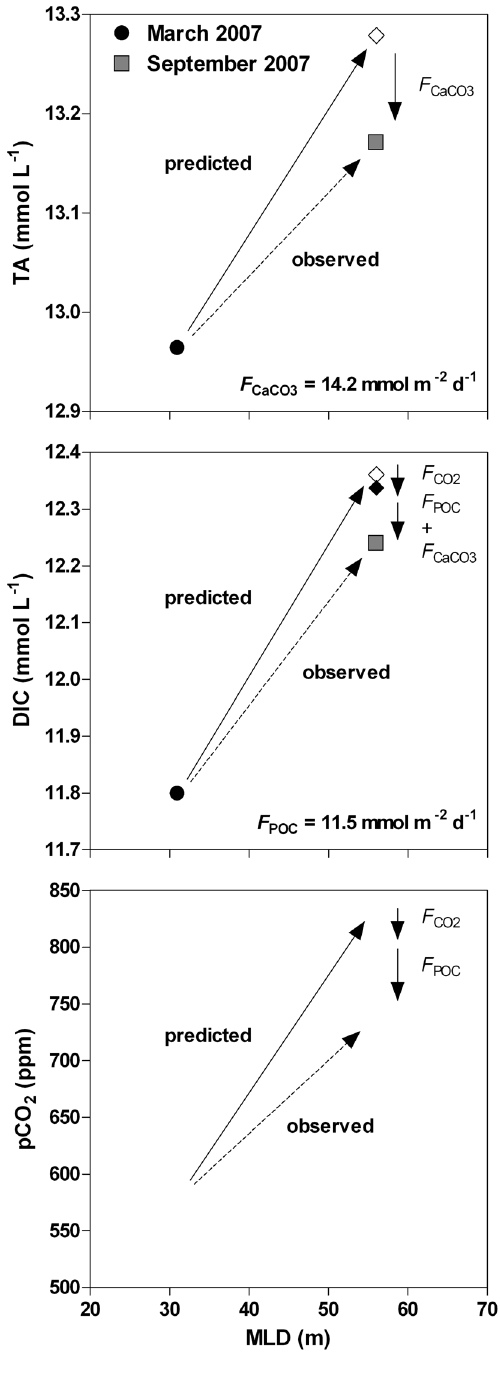
Figure 9. Observed data (circles and squares) and predicted values from a mixing model (diamonds) from March 2007 to September 2007 of total alkalinity (TA, mmol L 2 1 ), dissolved inorganic carbon (DIC, mmol L 2 1 ), and the partial pressure of CO 2 (pCO 2 , ppm) as a function of mixed layer depth (MLD, m) in the main basin of Lake Kivu. F CO2 = air-water CO 2 flux; F POC = export of particulate organic carbon to depth; F CaCO3 = export of CaCO 3 to depth.